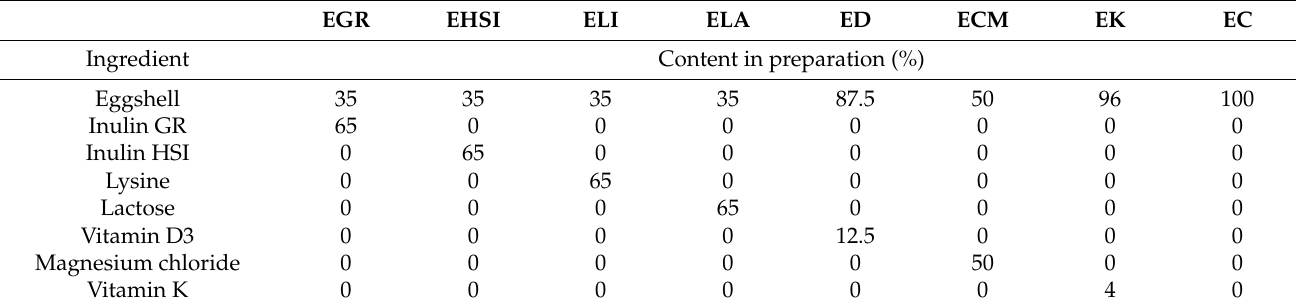
Table 4. Composition of the eggshell